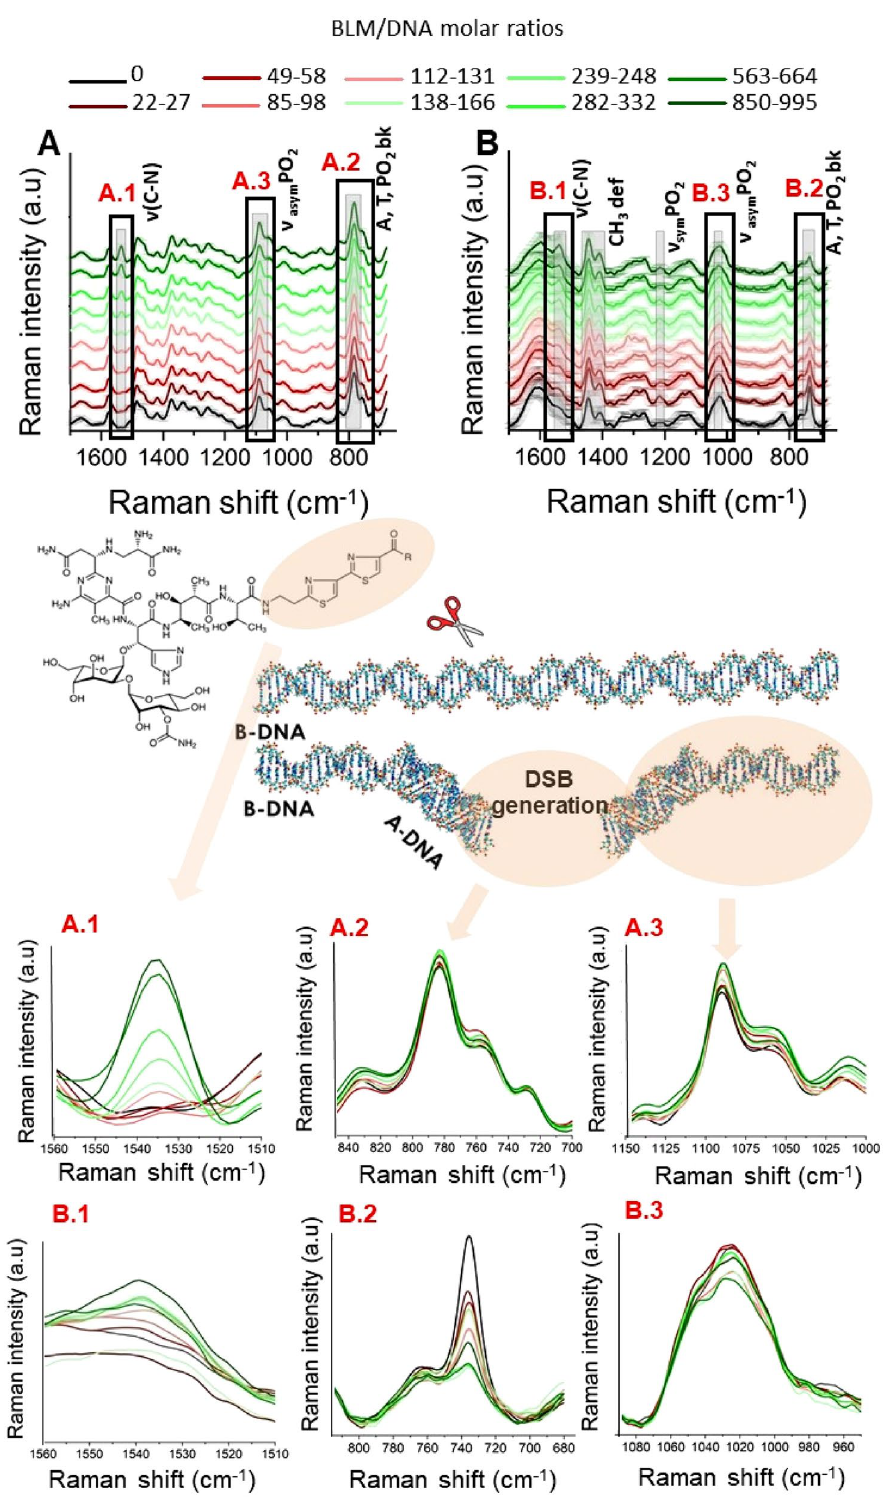
Figure 3. Molecular spectroscopy of DNA treated with bleomycin ( A ) Raman and ( B ) SERS spectra of DNA solutions: control and BLM treated, with the magnified area of the Raman band at 1535 cm −1 corresponding to bithiazole moiety present in the BLM molecule ( A.1 , B.1 ), C5 ′ –O–P–O–C3 ′ phosphodiester bonds band at 850–680 cm −1 ( A.2 , B.2 ) and symmetric stretching of phosphate at 1100–960 cm −1 ( A.3 , B.3 ) and the spectral ranges of nucleobases (A, T). The three bands are related to the presence of BLM ( A.1 , B.1 ), breaks of DNA backbone ( A.2 , B.2 ) and partial conformational transition of DNA ( A.3 , B.3 )